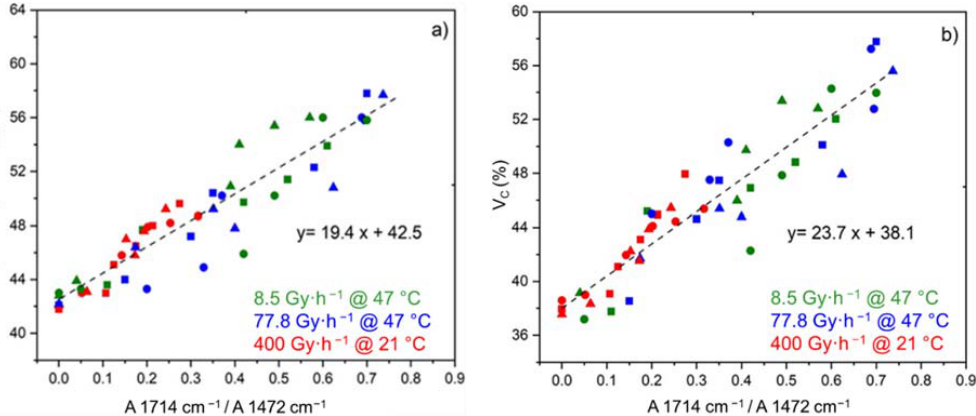
Figure 7. Mass ( a ) and volume fractions of crystals ( b ) versus carboxylic acid index for the Si ‐ XLPE matrix filled with 0 phr ( □ ), 25 phr ( ), and 50 phr ( ) of ATH and aged in air under 8.5 Gy ∙ h − 1 at 47 °C (green), under 77.8 Gy ∙ h − 1 at 47 °C (blue), and under 400 Gy ∙ h − 1 at 21 °C (red). As shown in Figure 8, chemi ‐ crystallization causes significant changes in the density of the Si ‐ XLPE matrix. As previously seen for both the oxidation (Figure 4) and chemi ‐ crystallization kinetics (Figure 6), the ATH fillers also have no influence on the densifica ‐ tion kinetics of the Si ‐ XLPE matrix.